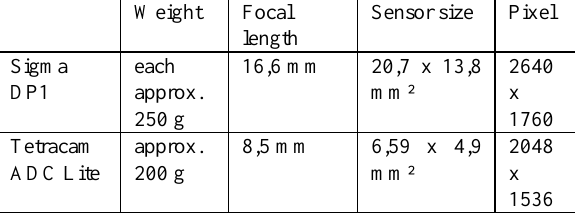
Table 3. Technical data of the